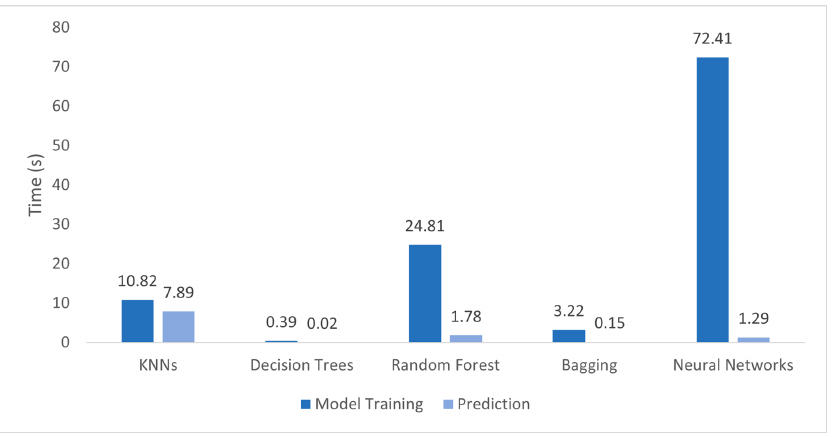
Figure 11. Computational time